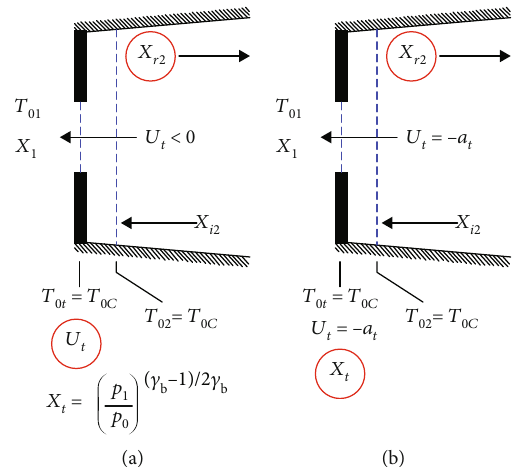
Figure 9: Boundary constraints and unknown parameters for (a) subsonic and (b) choked out fl ow (unknowns